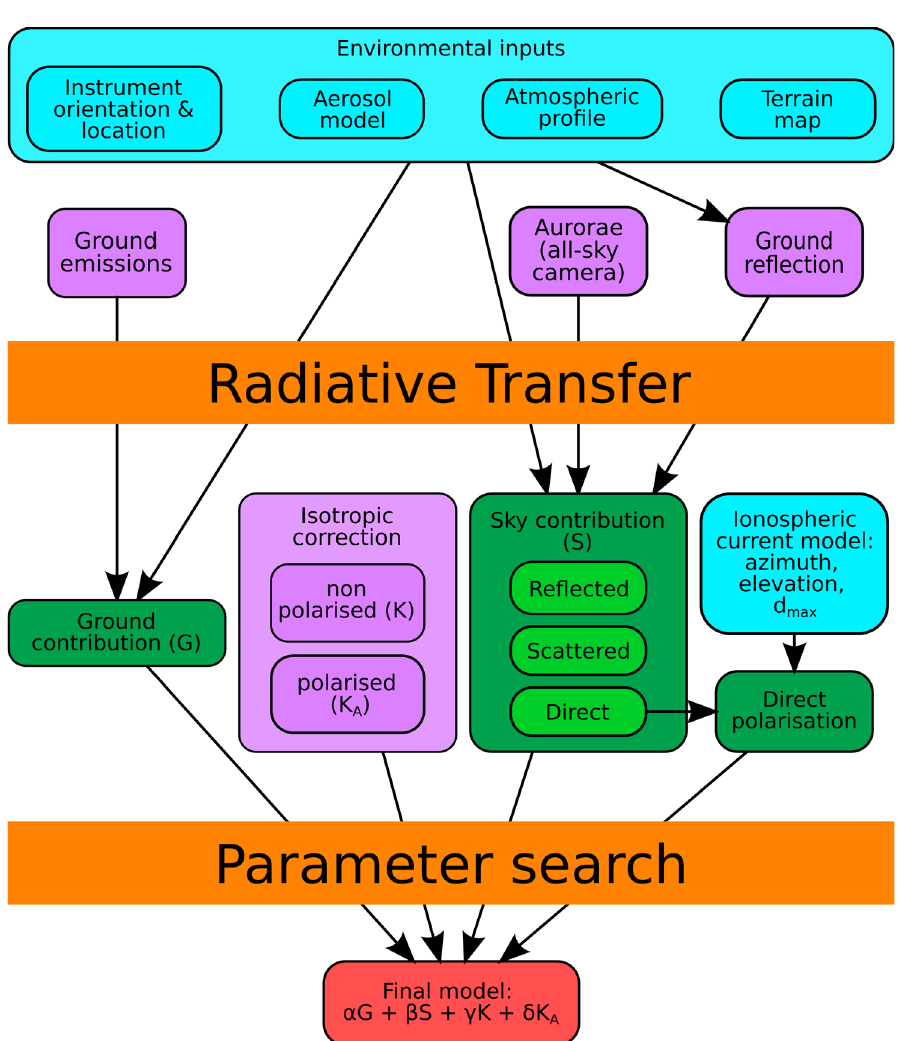
Fig. 2. POMEROL fl owchart. Blue boxes: additional environmental inputs. Pink boxes: input emissions. Green boxes: Ground ( G ) and sky ( S ) models. Orange bands: main steps of the process. Red box: Final outputs in the same format as the